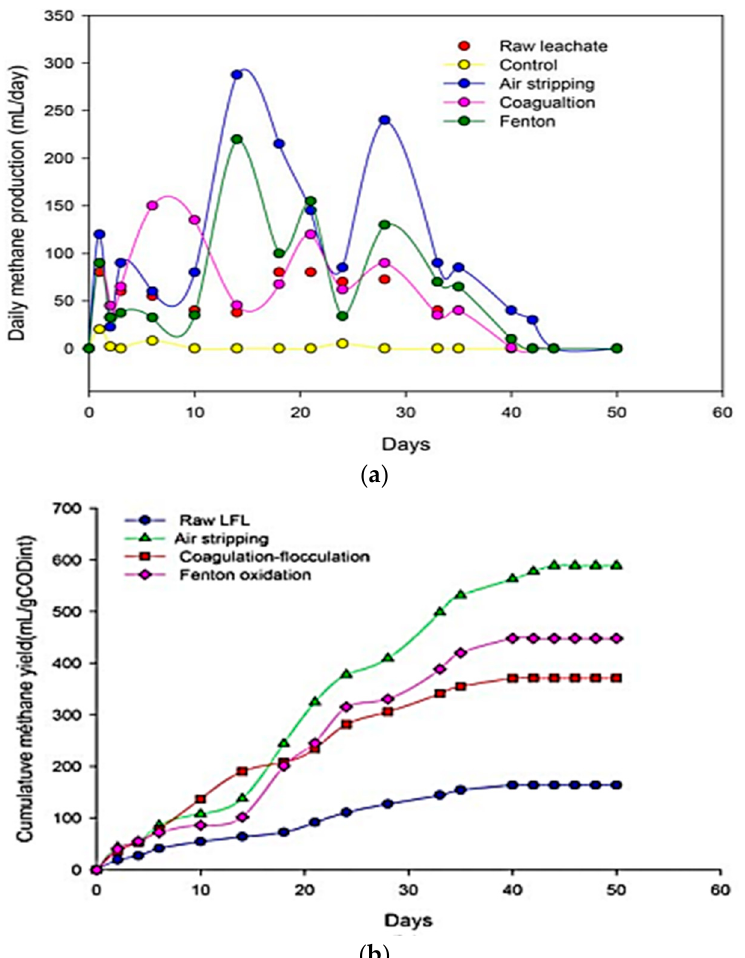
Figure 5. Methane production during batch anaerobic treatment of landfill leachate ( a ) daily methane production rate, ( b ) cumulative methane production